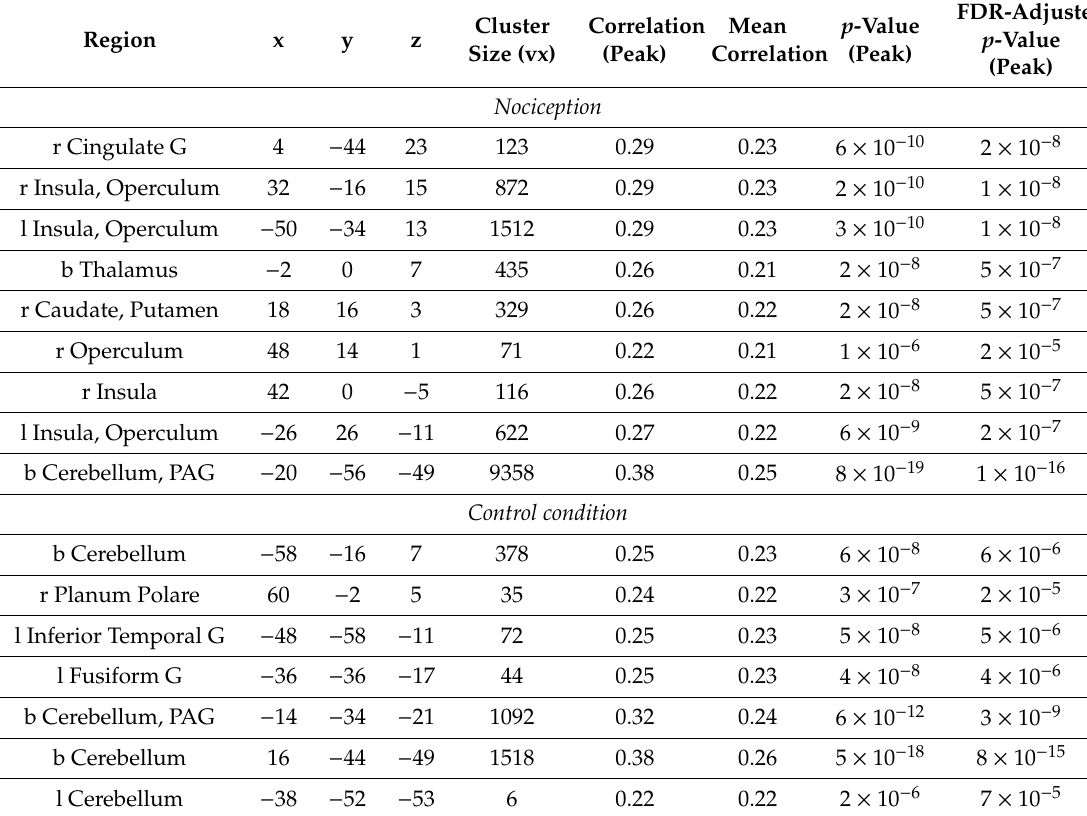
b = bilateral, l = left, r = right, G = Gyrus, PAG = Periaqueductal Grey.